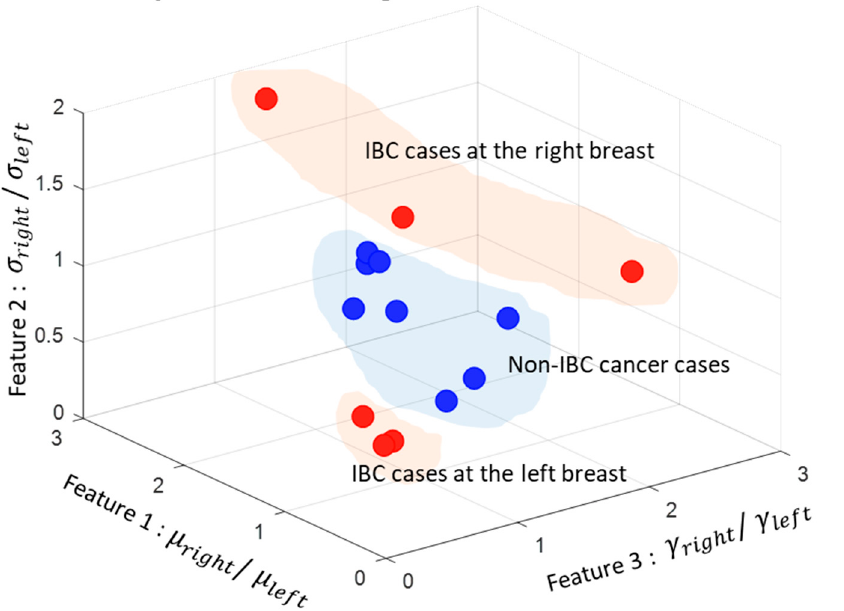
Figure 6. Three-dimensional (3D) illustration of the three features calculated from digital bilateral mammograms for IBC and non-IBC cancer cases. This figure is best viewed in color.